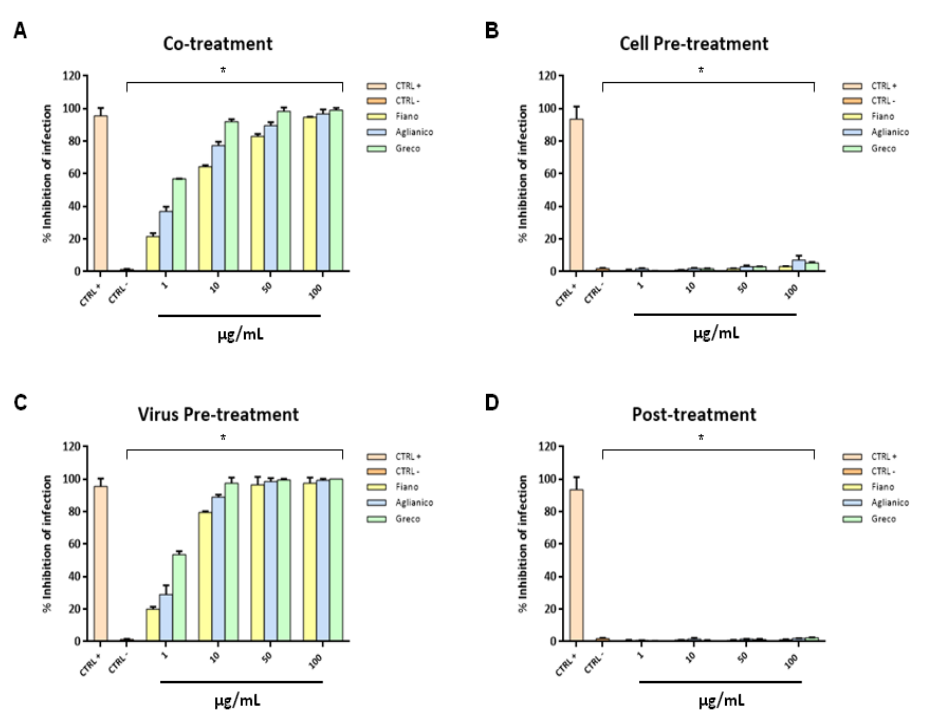
Figure 8. Antiviral activity against HSV-1 of extracts at pH 13.00. Different assays were performed in order to evaluate anti-HSV-1 activity. Extracts inhibited the early stages of infection, acting in co-treatment ( A ) and virus pre-treatment ( C ) assays. Extracts were not able to interact with the cellular surface ( B ) or block the viral replication ( D ). Statistical differences were evaluated via two-way ANOVA; a value of p ≤ 0.05 was considered significant, with * p ≤ 0.0001.